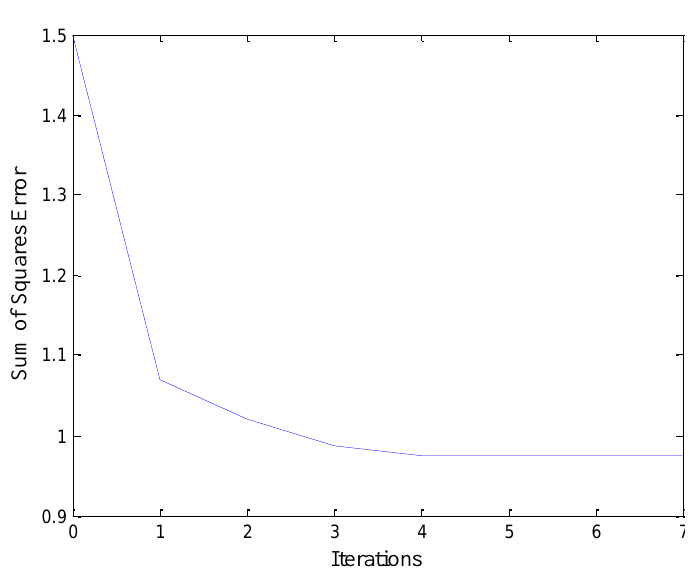
Figure 5. Cost function of